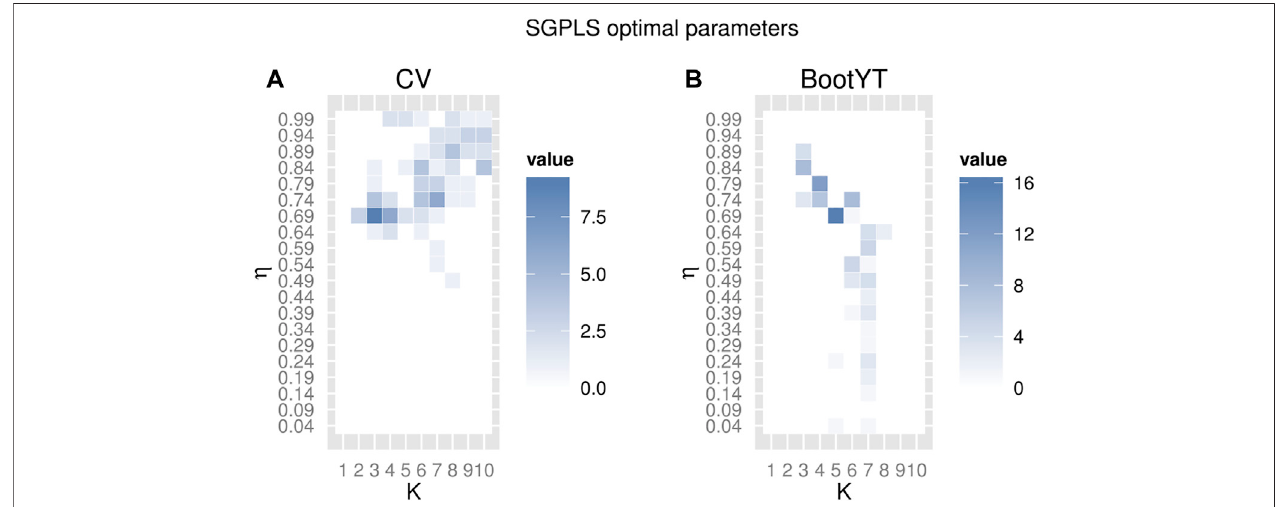
FIGURE 4 | Repartition of selected sets of tuning parameters over the 100 trials, for SGPLS CV (A) and SGPLS BootYT (B) .